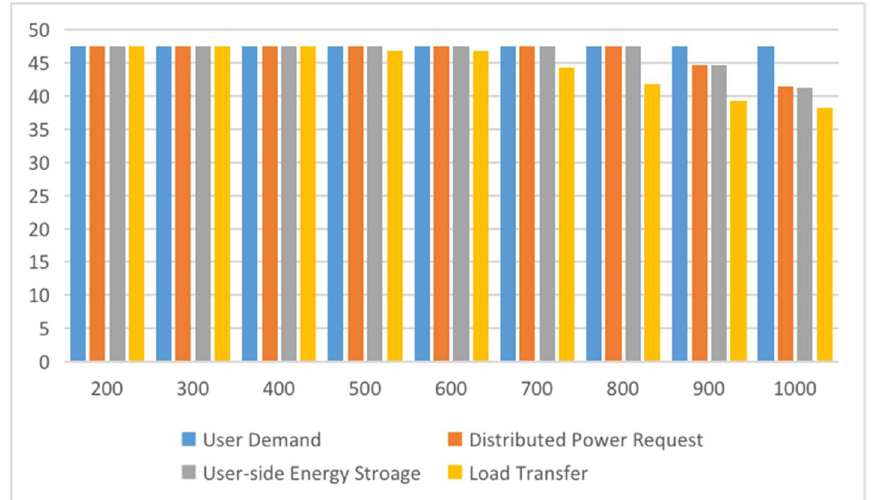
Figure 5. Energy Consumption of Each Customer using different methods.